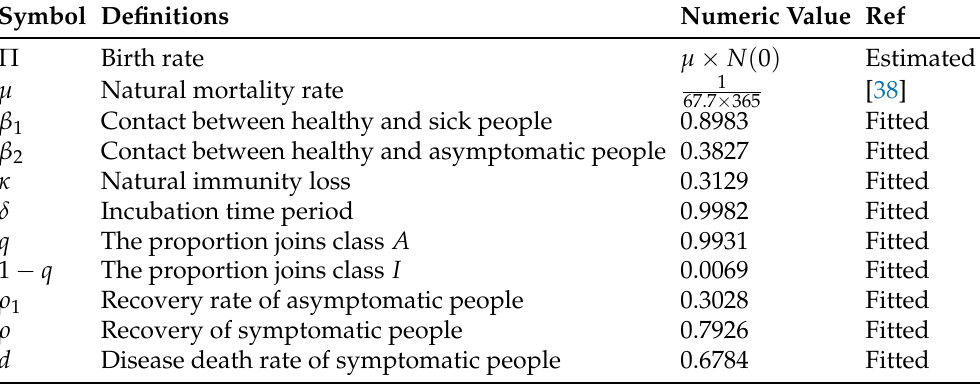
Table 1. Parameter